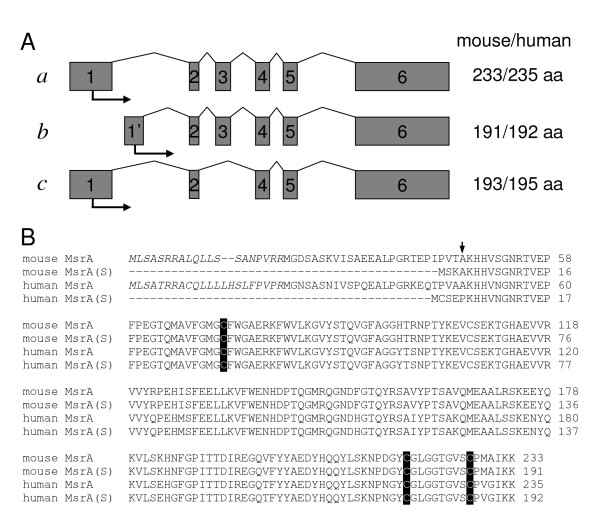
Splice variants of mouse and human MsrA. (A) Schematic illustration of genomic structures of alternatively spliced MsrA forms in humans and mice. Translation initiation sites are indicated by arrows. Exons are shown by boxes and are numbered. The number of residues in each of the human and mouse forms is indicated on the right. (B) Alignment of mouse and human mitochondrial MsrAs (the a form in A) and MsrA(S)s (the b form in A). The mitochondrial signal peptide is indicated in italics. The catalytic cysteine in the GCFWG sequence and two cysteine residues in the last exon are highlighted. The arrow indicates the last amino acid residue of exon 1.